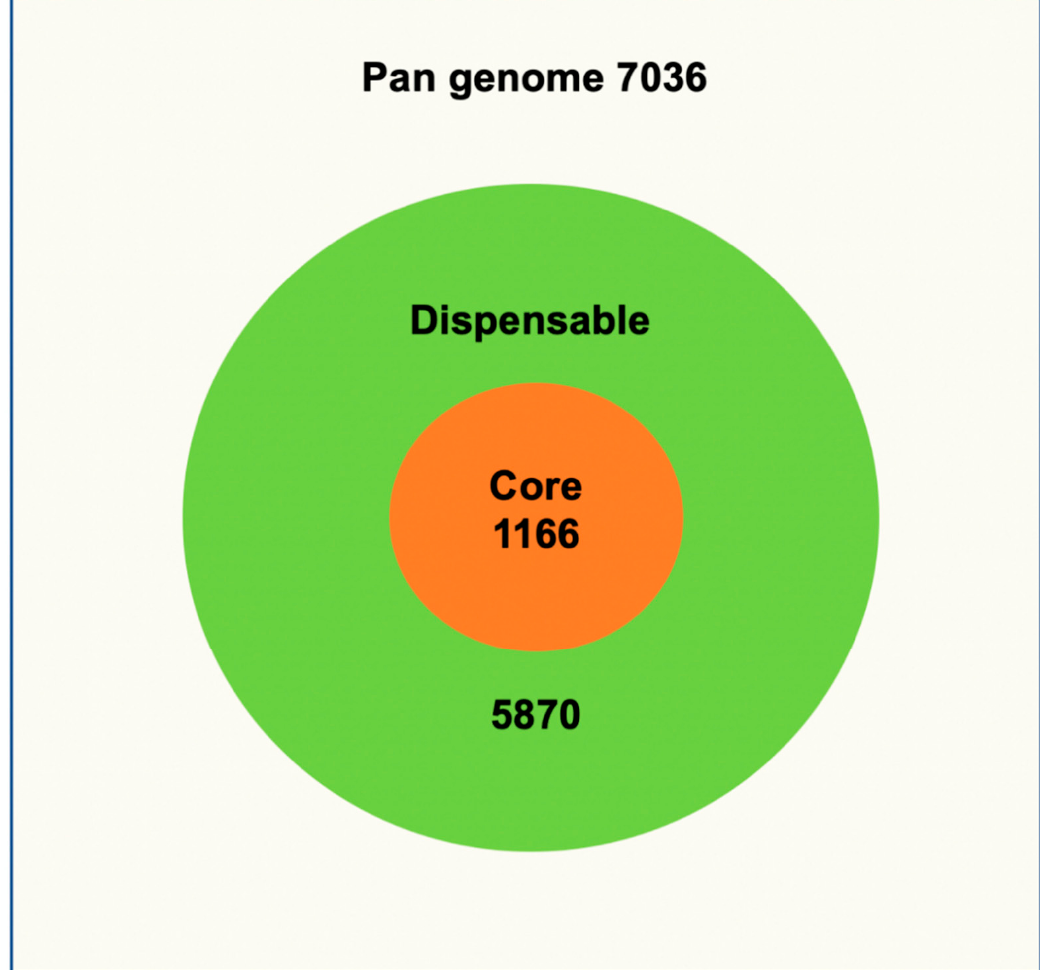
Figure 1. MTB pan/core genome. The core genome is listed with orange background and the all the remaining genes (dispensable) part of the pan genome are listed with the green background.